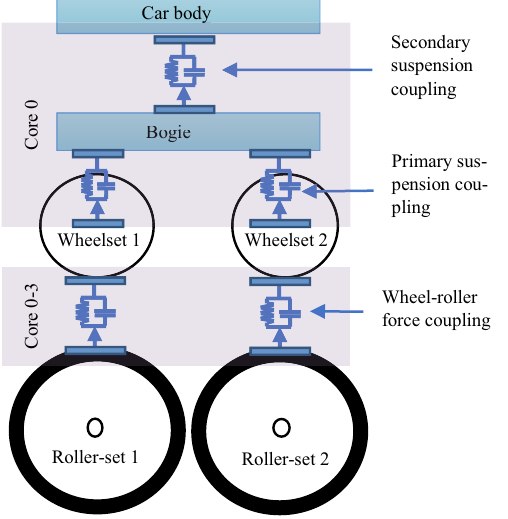
Fig. 11 Assignment of CPU core on the wheel–roller force coupling elements